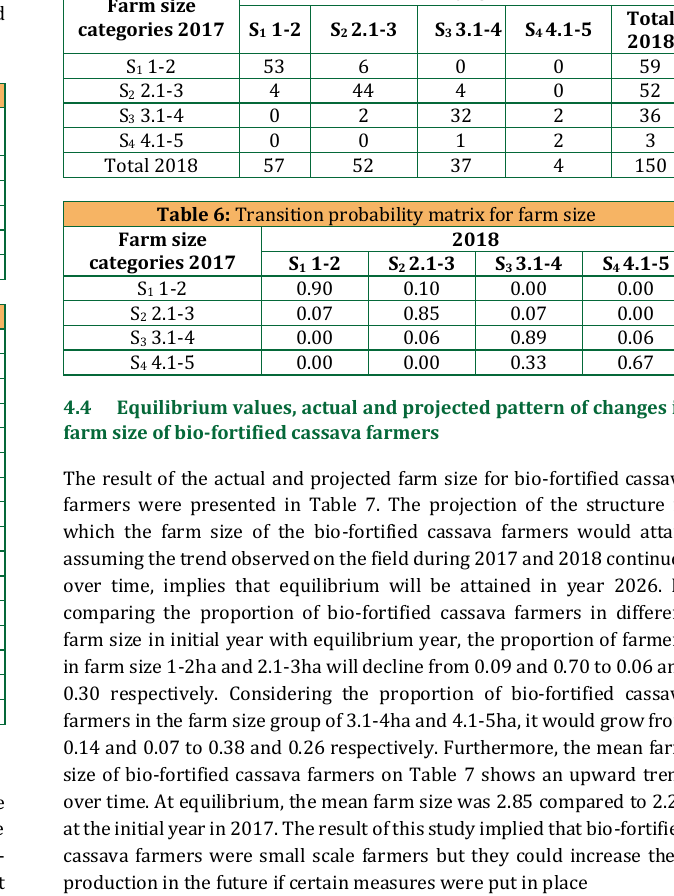
Table 5: Transition matrix for farm size categories